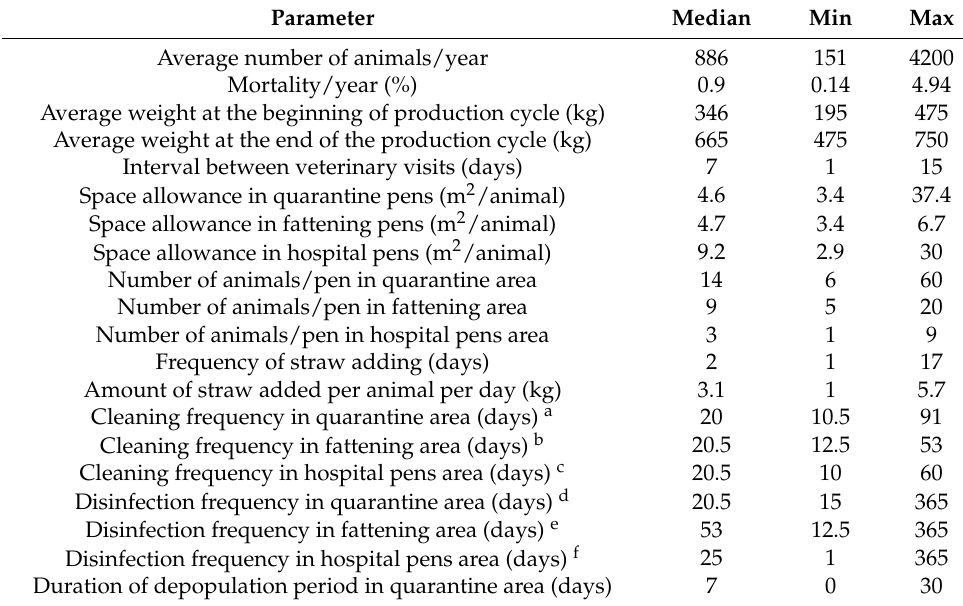
Table 1. Characteristics of the farms and the animals of 26 beef calves fattening operations located in northwestern Italy are reported as the median, minimum, and maximum for the two-year period (2014 and